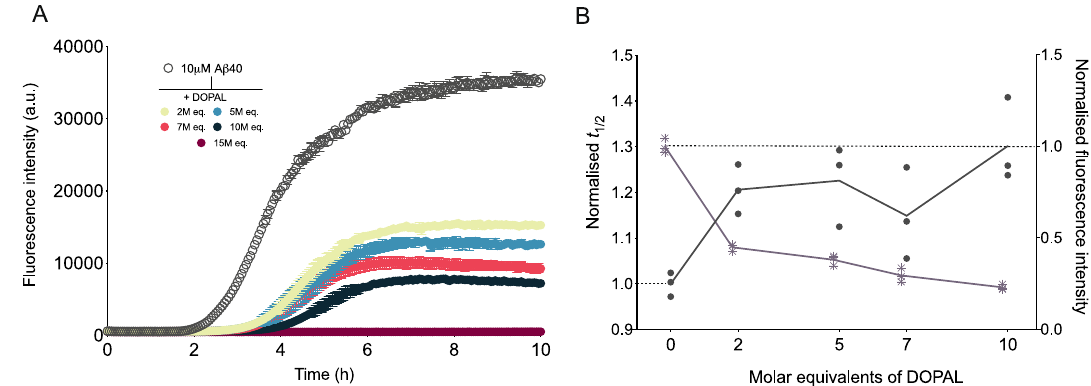
Fig. 2 DOPAL inhibits A β 40 fi bril formation in a dose-dependent manner. a Aggregation kinetics of A β 40 in NaP pH 6.9, 0.2 mM EDTA in the absence (empty circles) and presence ( fi lled circles) of increasing molar equivalents of DOPAL (represented in different colours). b Normalised to control (absence of DOPAL) half-time ( t 1/2 ) of aggregation (points) and end point fl uorescence intensities (asterisks) as derived from the data in a . Throughout, error bars represent means± SEM of three